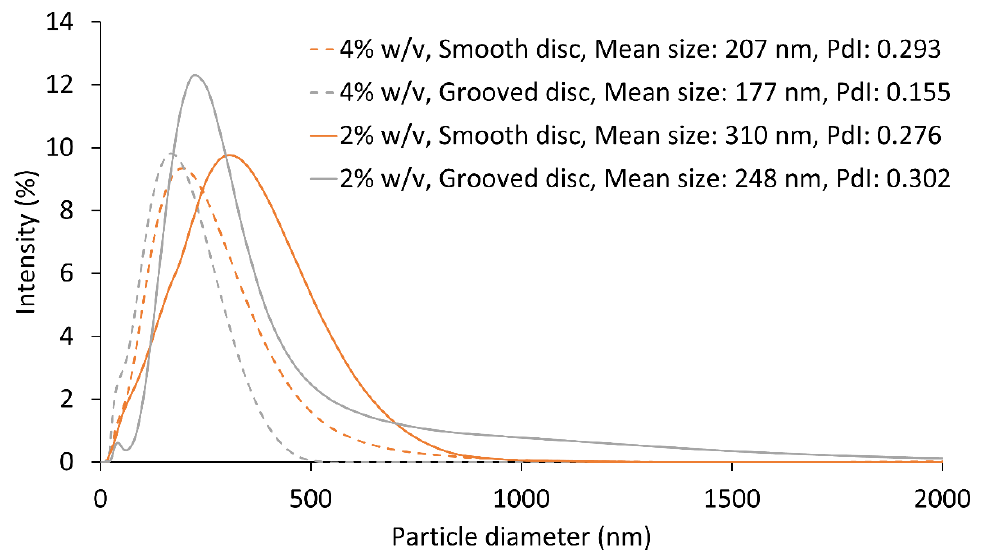
Figure 10. Effect of concentration on PSD at 6 mL/s, 1200 rpm, and 9:1 ratio for both grooved and smooth disc surfaces.